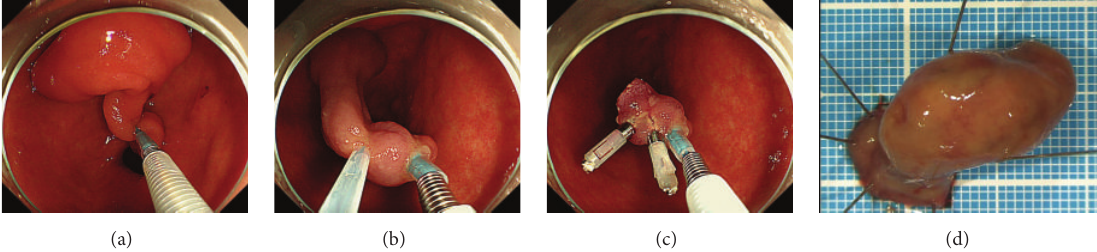
Figure 3: Endoscopic resection of the polyp. During the procedure, the stalk was strangulated with a detachable snare (a). The polyp was then resected by snare polypectomy (b). The cut surface was closed with two metal clips (c). The size of the resected specimen was 26 × 19mm (d).